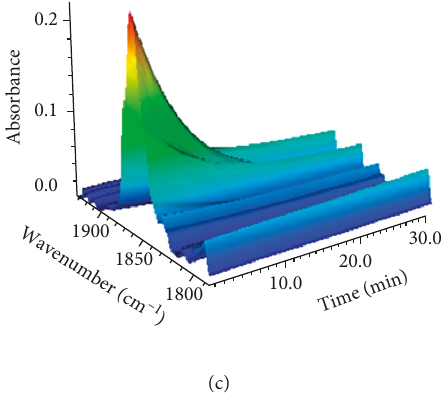
Figure 6: Time resolution of FT-IR spectra of [RuCl